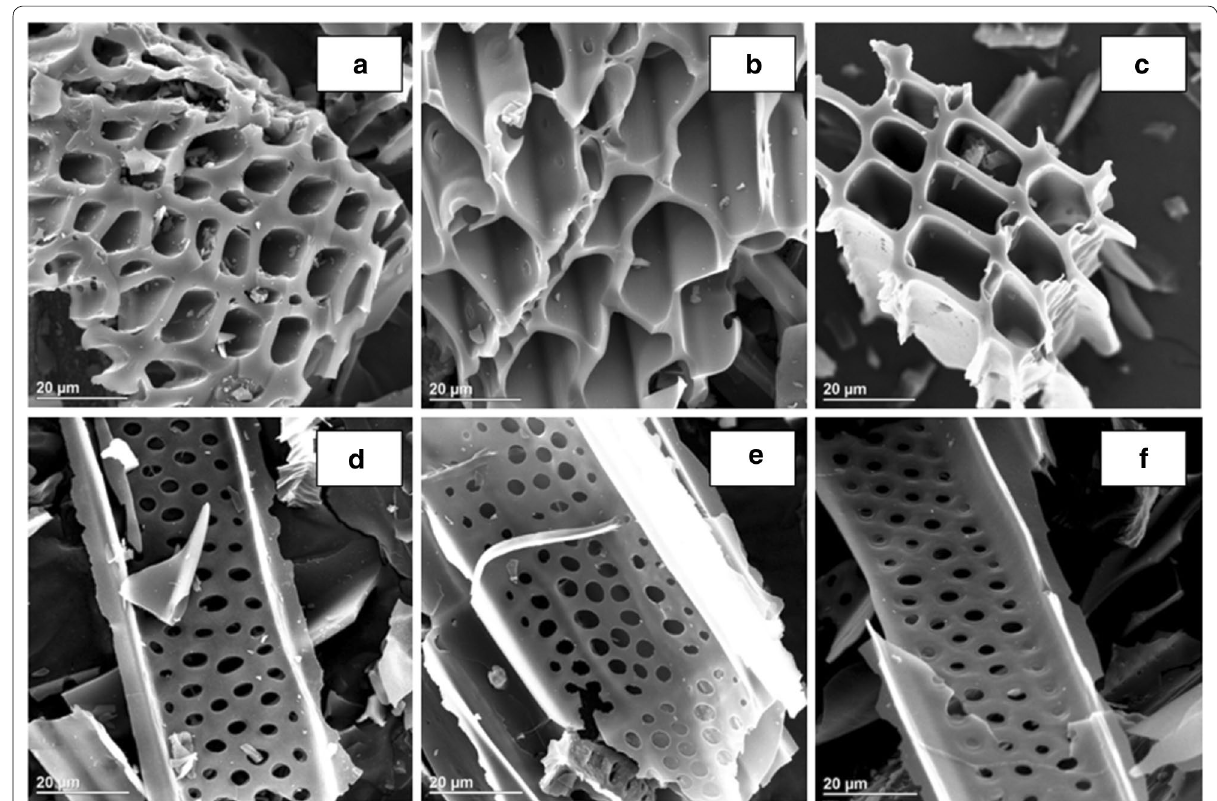
Fig. 6 SEM images of softwood ( a , b , c ) and hemp ( d , e , f )